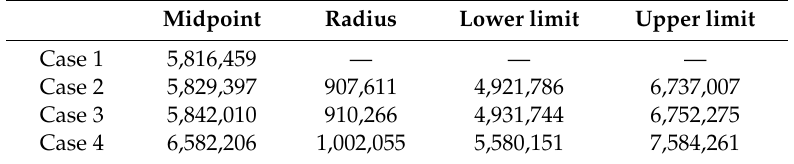
Table 2. Midpoint, radius, lower limit and upper limit of interval of total annual cost in the four cases ($). Midpoint